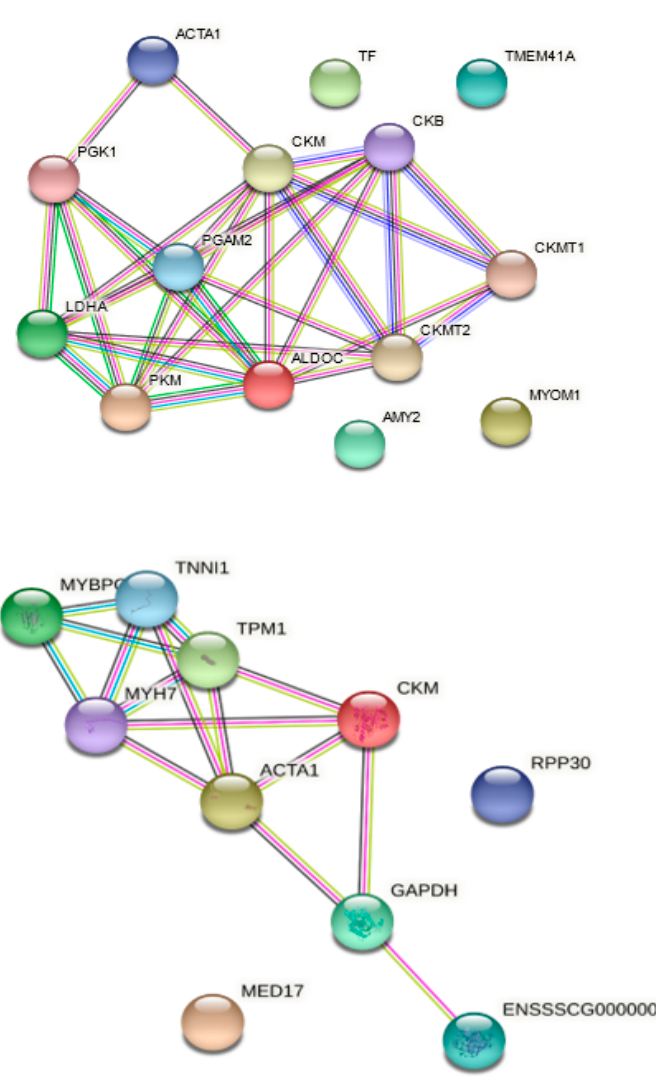
Figure 1. Functional interaction network linking the WSF (above) and SSF (bellow) identified from the peptides released during the aging of dry-cured pork loins (protein names according to Uni- ProtKB).